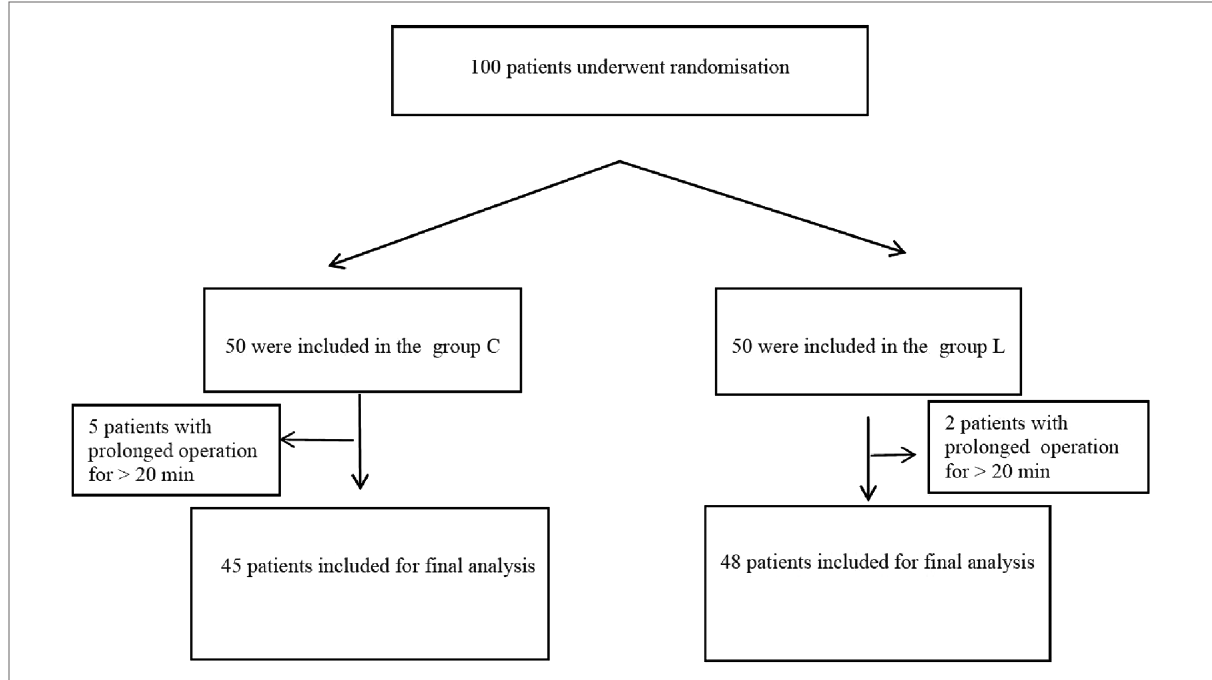
FIGURE 1 Consort fl owchart.